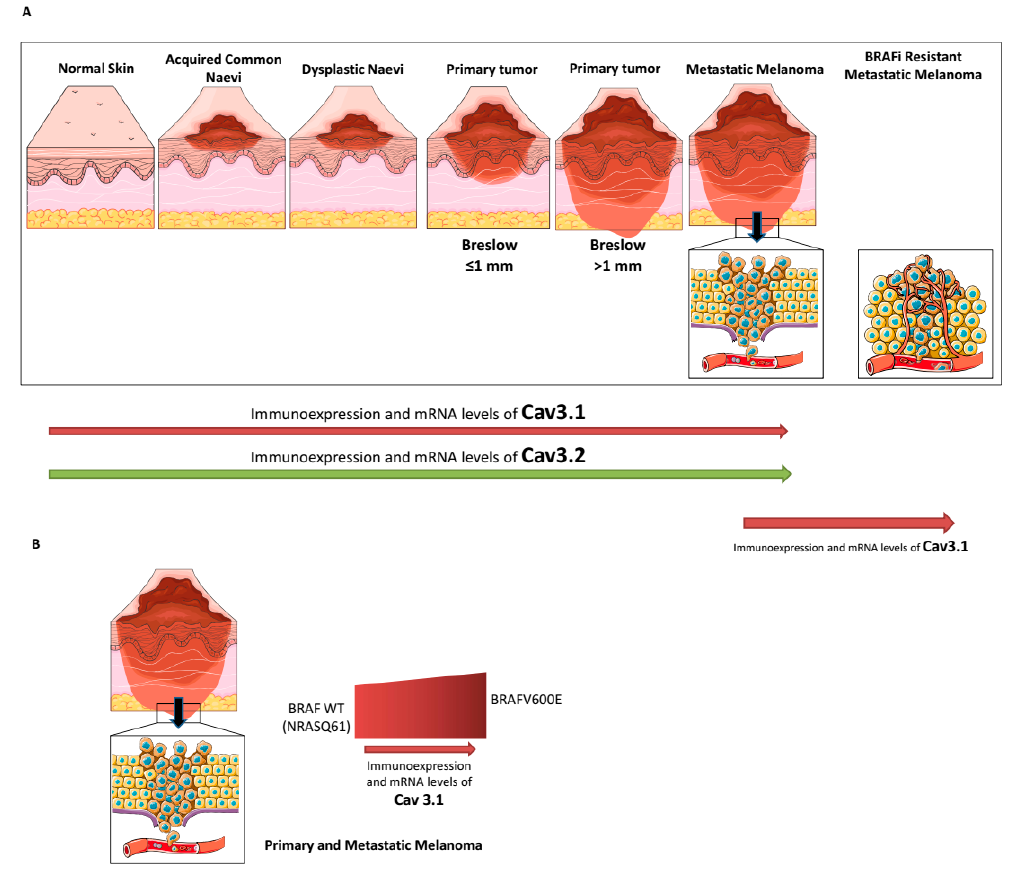
Figure 1. Cav3.1 and Cav3.2 T-type calcium channel (TTCC) expression during the progression of melanoma and depending on genetic profile. ( A ) Increased expression of Cav3.1 and Cav3.2 during melanoma progression (Clark model) and after acquisition of resistance to BRAF inhibitors (the last in the case of BRAF V600E melanoma). ( B ) Expression of Cav3.1 in primary and metastatic melanoma depending on genetic profile (BRAF V600E vs. non-BRAF-mutant melanoma).